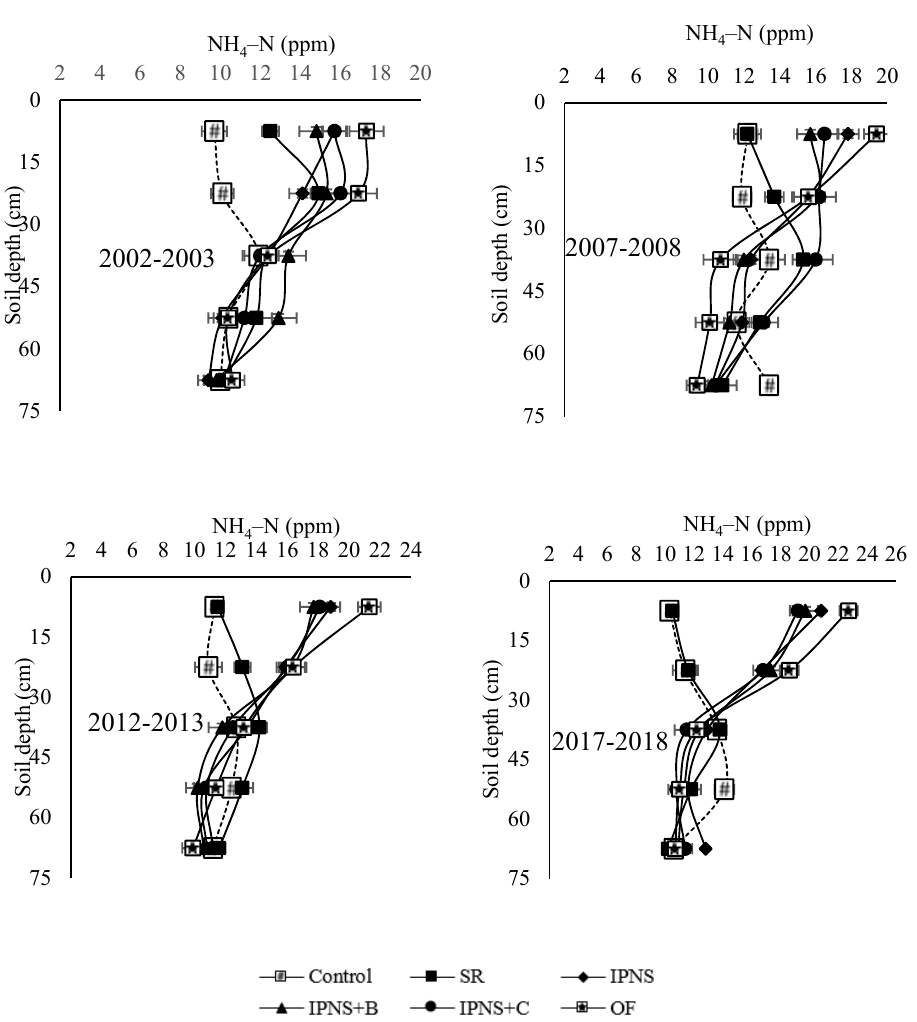
Figure 5. Effect of nutrient management options on the distribution of the ammonium–N content in different soil profiles after wheat harvest at five-year intervals of the RWS cycle. Bars indicate the standard error of the mean, n = 4.